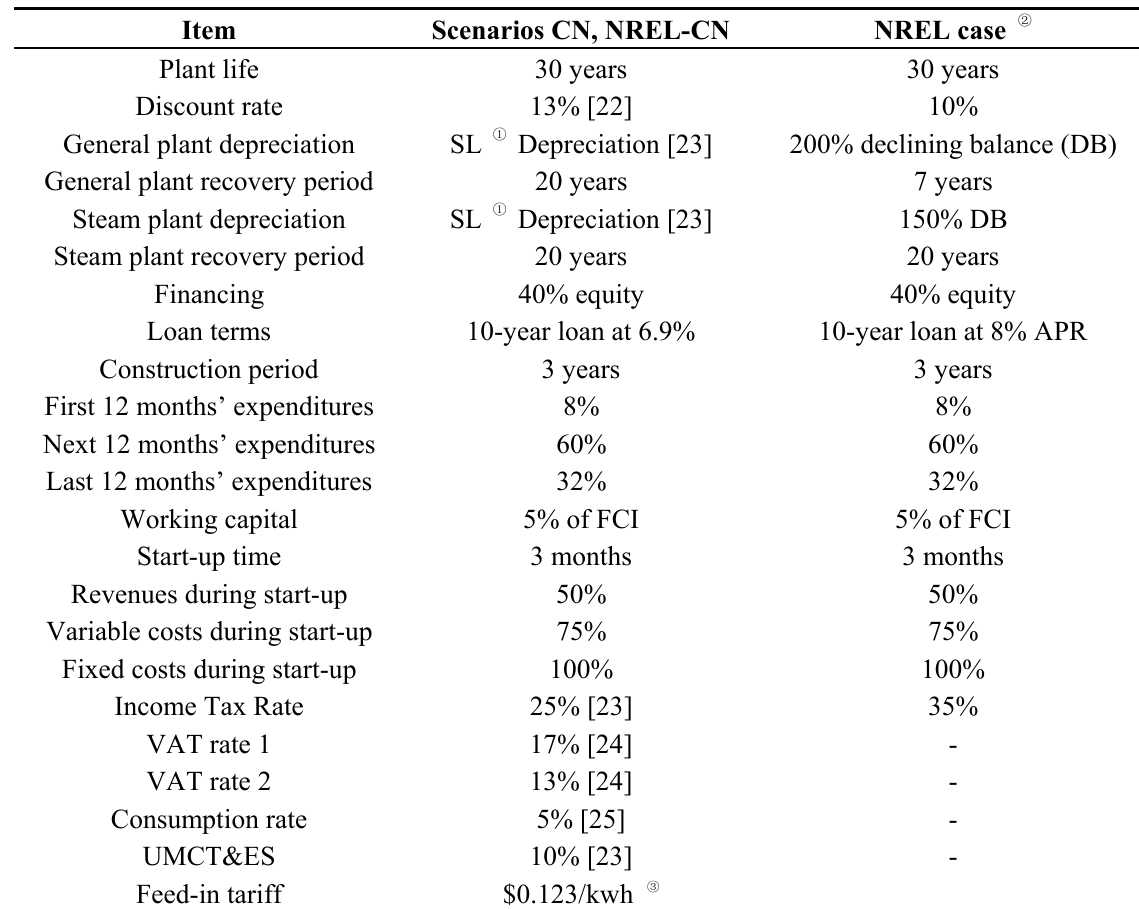
Table 5. Economic parameters for discounted cash flow